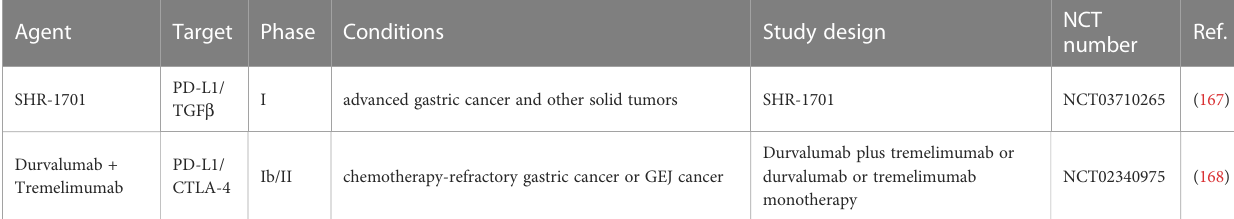
TABLE 2 Overview of the latest representative clinical trials of ICIs in colorectal cancer.